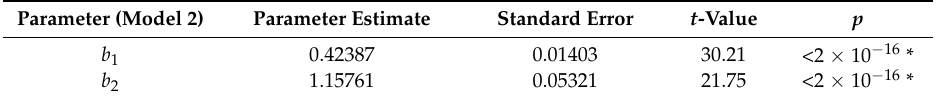
Figure 6. Plot of the log-likelihood function as a function of λ for the variable transformation y ′ = y α . Table 5. Results of the OLS regression of Model 2 on the test data set. Table 5. Results of the OLS regression of Model 2 on the test data set. Parameter (Model 2)